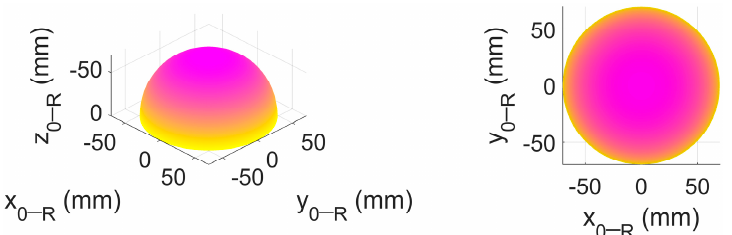
Figure 10. Enveloping surface of the experiment validation for the dexterous manipulation. When the last two axes J 4 and J 5 traversed the motion ranges [ − π , π ] and [ 0, π ] , respectively, as shown in Figure 9, it can be found that the total locus of the tool tip of the end-e ff ector appeared as an approximate enveloping half-spherical surface with a downward open, as shown in Figure 10, and the center of the half-spherical surface was the intersection of the last two axes J 4 and J 5 . In addition, the total locus of the tool tip remained the same when the last two axes J 4 and J 5 traversed the motion ranges [ − π , π ] and [ − π , 0 ] , respectively. For the sake of simplicity, only the former case is illustrated in Figure 9. Note that the approximate enveloping half-spherical surface was not a strictly half-spherical surface, and the extremely small di ff erence was caused by the structure parameter e , which was not strictly equal to zero due to assembly